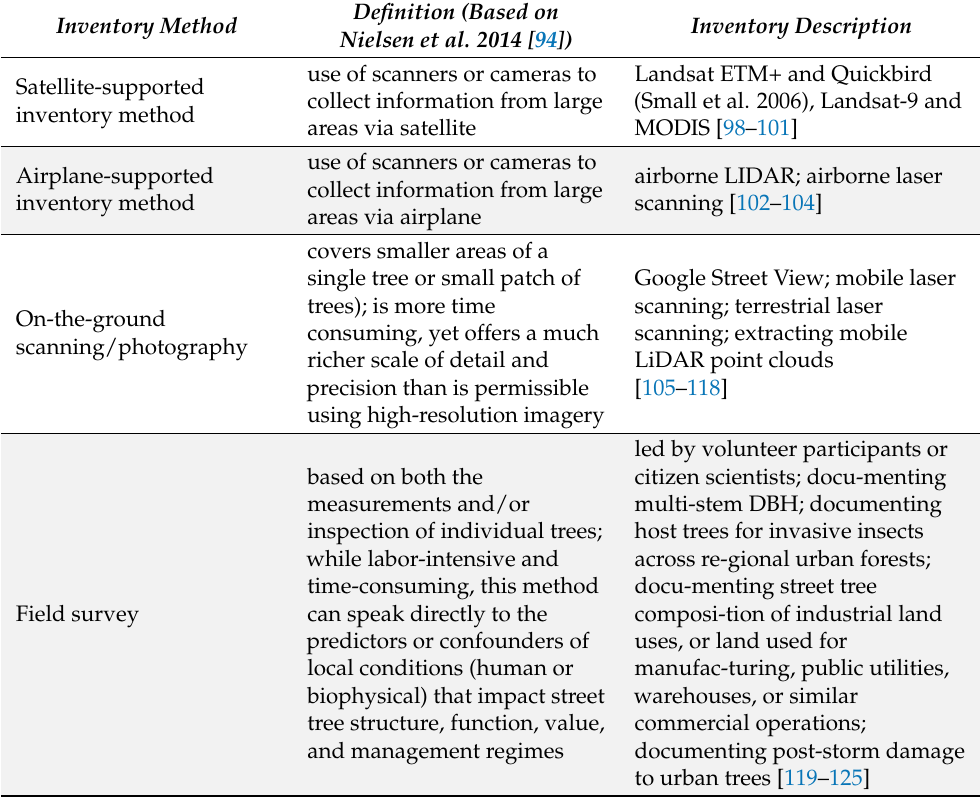
Table 3. Summary of records across street tree inventory methods. Full listing available in Supple- mentary